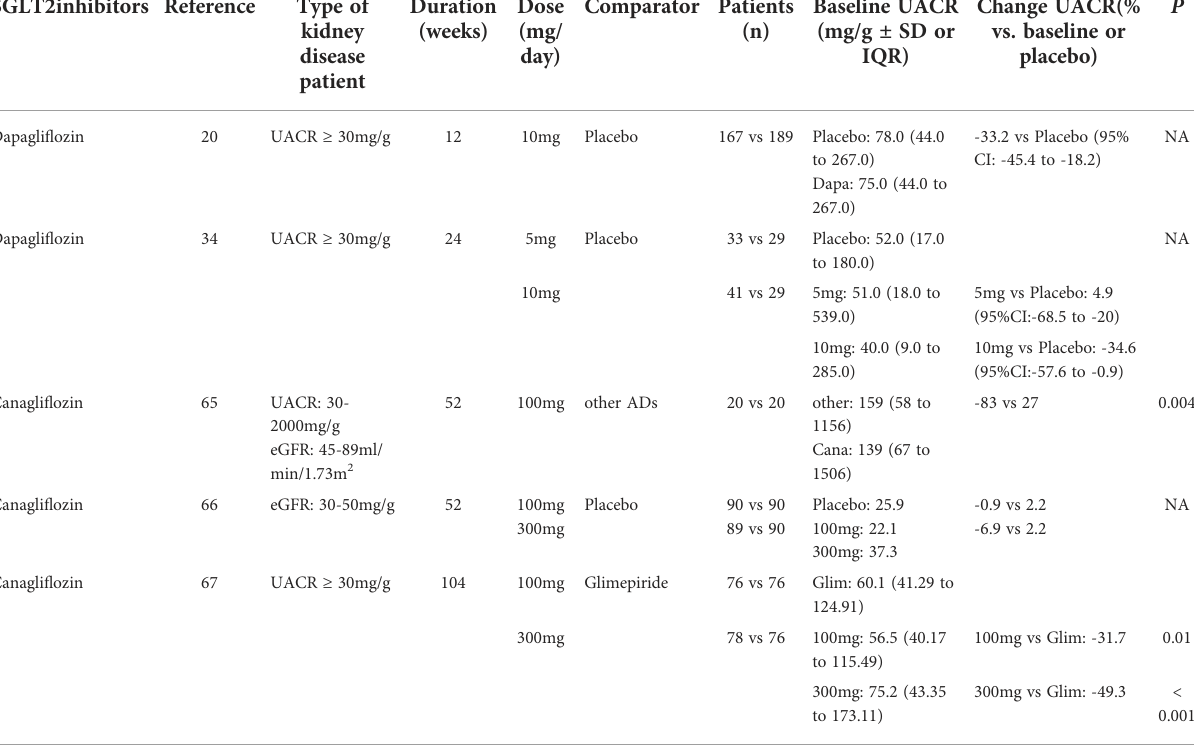
TABLE 2 Effects of Sodium-glucose cotransporters 2 (SGLT2) inhibitors on urinary albumin creatinine ratio (UACR) in randomized controlled trials (RCTs) in patients with type 2 diabetes and chronic kidney disease (CKD) of different levels. SGLT2inhibitors